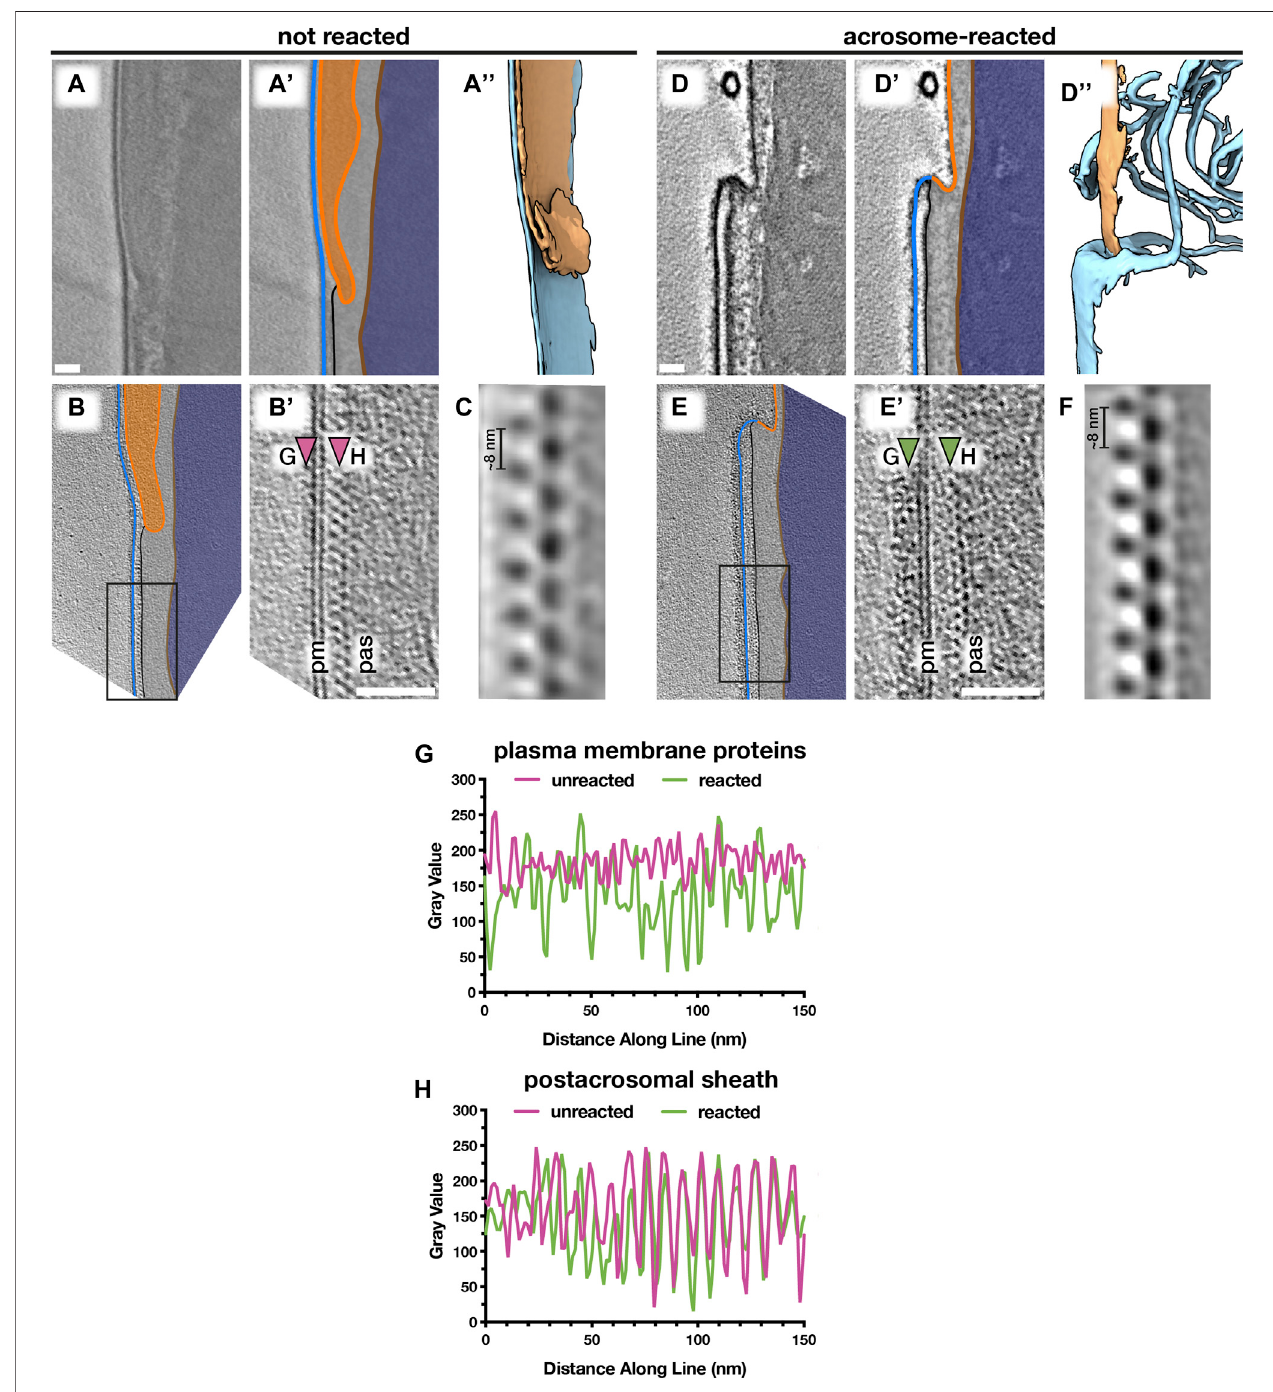
FIGURE 5 | Acrosomal exocytosis transforms the molecular landscape of the sperm plasma membrane. Comparing the post-acrosomal plasma membrane in unreacted (A – C) versus acrosome-reacted (D – F) reveals major differences in membrane protein decoration. (A,D) Computational slices (A and A ’ ,D and D ’ ) and corresponding three-dimensional reconstructions (A ’’ ,D ’’ ) of VPP cryotomograms illustrating how acrosomal exocytosis remodels the topography of the equatorial region. (B,E) Computational slices through defocus-contrast cryotomograms illustrating how the post-acrosomal plasma membrane becomes densely packed with membrane proteins after acrosomal exocytosis. (C,F) Subtomogram averages of the post-acrosomal sheath from unreacted (C) and acrosome-reacted (F) cells. (G,H) Exemplary linescans illustrating changes in membrane protein density after the acrosome reaction (G) , as well as the lack of noticeable change in the post- acrosomal sheath (H) . Linescans were taken at the approximate locations marked by arrowheads in (B ’ ) and (E ’ ) . Scale bars: 50 nm. Labels: pm, plasma membrane; pas, post-acrosomal sheath. Color scheme: blue — plasma membrane, orange — outer and inner acrosomal membranes, light gray — perinuclear theca and post- acrosomal sheath, brown — nuclear envelope, dark blue — nucleus.